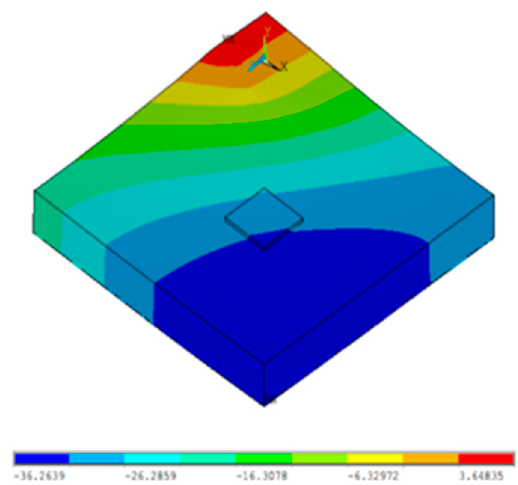
Figure 16. Deformation shape of BS1 slab.